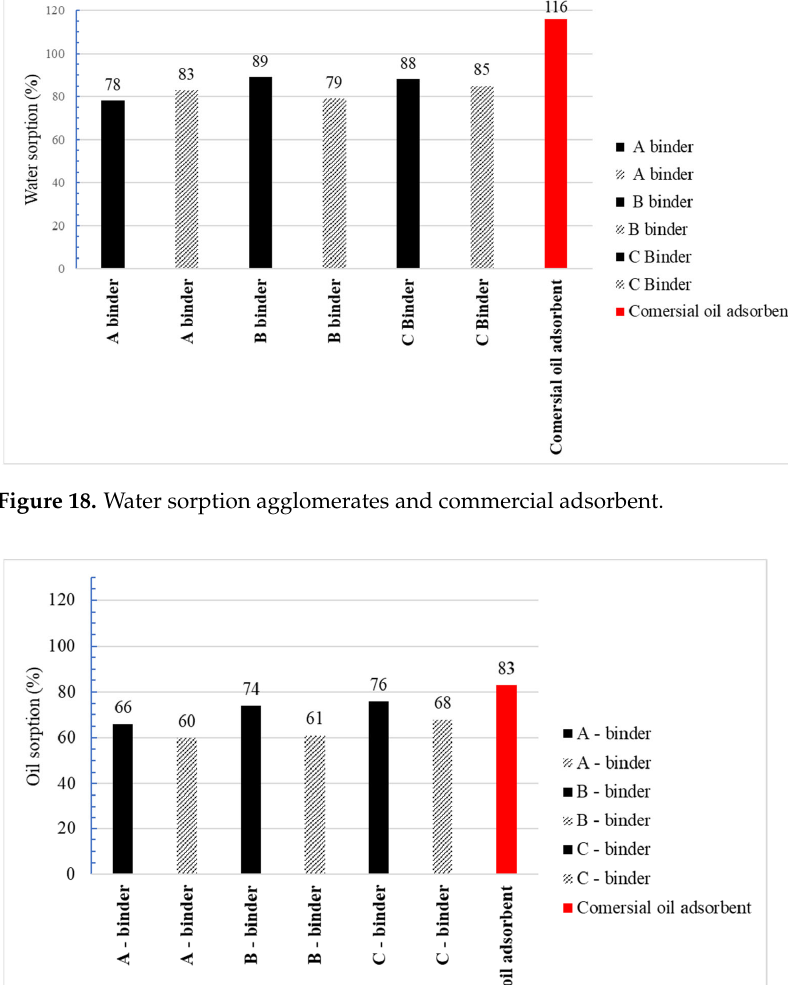
Figure 17. Efficiency of the dry agglomeration processes.